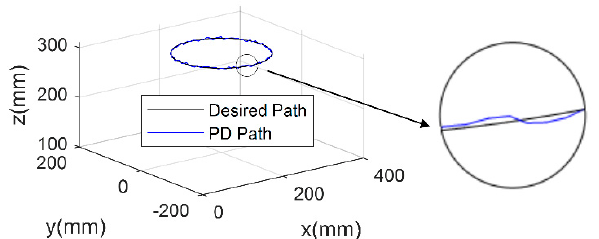
Figure 7. PD-based trajectory tracking controller experimental result.